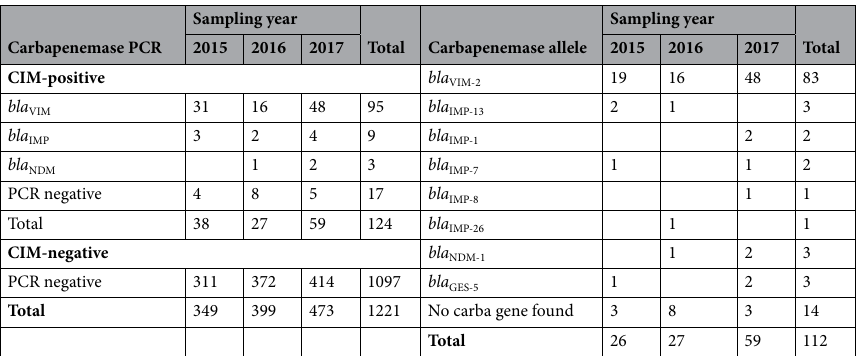
Table 1. Distribution of carbapenemase genes in CIM-positive P. aeruginosa isolates collected within the Netherlands between 2015 and 2017. In the left table, the results from CIM tests and multiplex PCRs for all isolates included in the study are shown. From 1221 P. aeruginosa isolates that were included, 124 (10%) were CIM-positive. In 107 CIM-positive isolates, a carbapenemase gene was also detected. All bla KPC and bla OXA-48 PCRs were negative, and are therefore not shown. In the right table, NGS results are shown. From the 124 CIM-positive isolates, 112 were sequenced, and the bla VIM-2 allele was discovered in 83 (74%) isolates. VIM Verona Integron-encoded Metallo-beta-lactamase, IMP Imipenem Metallo-beta-lactamase, NDM New Delhi Metallo-beta-lactamase, GES Guiana Extended-Spectrum beta-lactamase, Carba